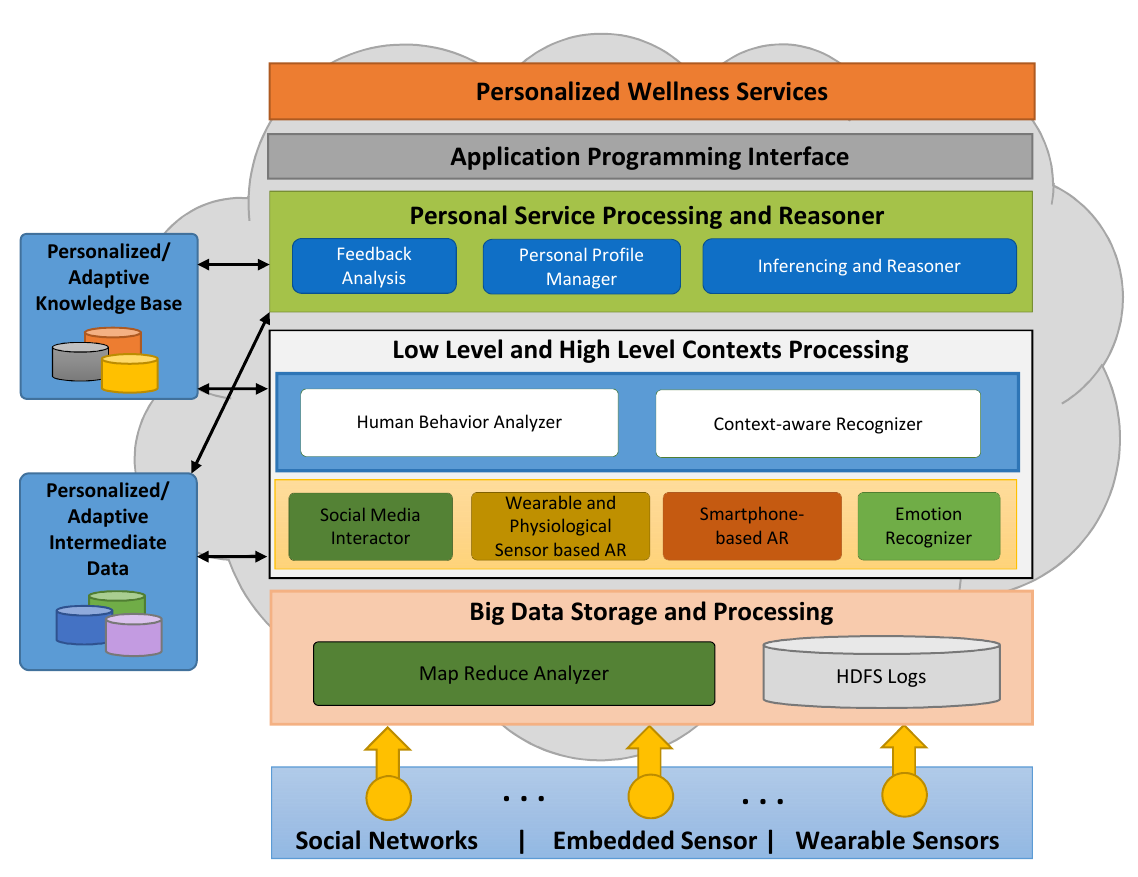
Figure 1. An overview of ATHENA platform.